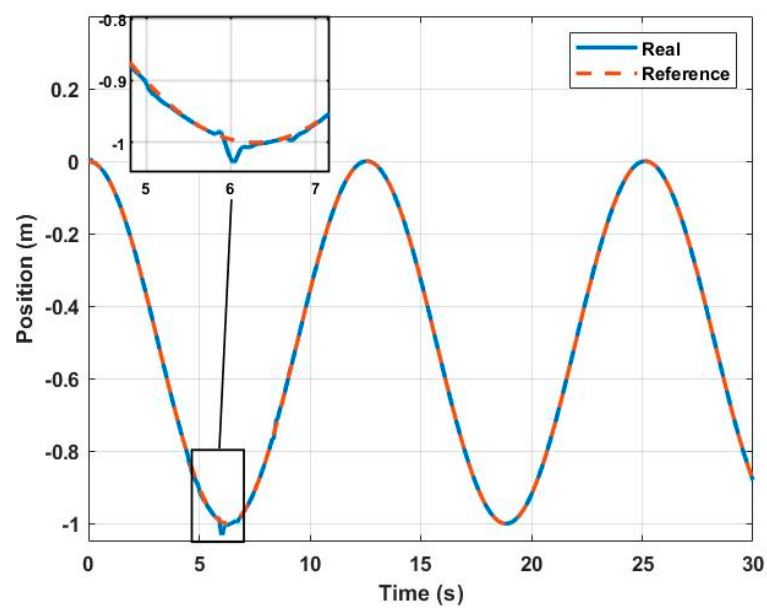
Figure 14. Helicoidal trajectory with perturbance. Real ( 𝐵𝑙𝑢𝑒 𝑆𝑜𝑙𝑖𝑑 𝑙𝑖𝑛𝑒 ) vs. desired ( 𝑅𝑒𝑑 𝑑𝑜𝑡𝑡𝑒𝑑 𝑙𝑖𝑛𝑒 ).